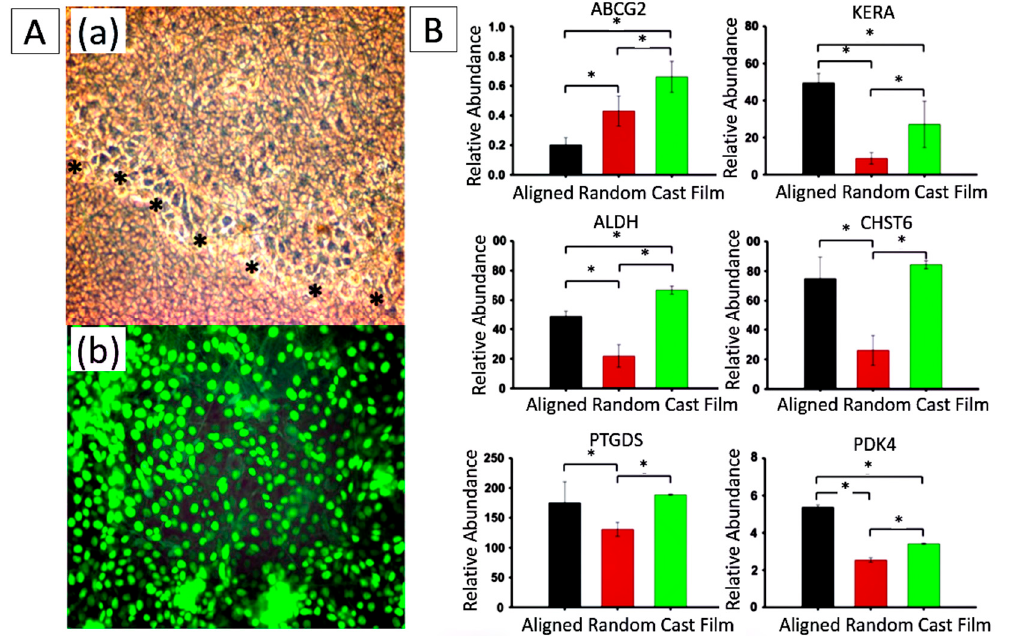
Figure 6. ( A ) Biocompatibility assessment of electrospun PCL nanofibers. ( a ) Phase contrast picture shows migration of human corneal epithelial cells over nanofibers (black stars line); ( b ) Epithelial cell sheet demonstrates high viability ratio of human corneal epithelial cells on nanofibers by their positive green staining. Cells were observed at 200× magnification. Reproduced from [14], with permission from © 2011 Molecular Vision; ( B ) Changes in gene expression of hCSSCs seeded on aligned fibrous substrates (black), random fibrous substrates (red) and cast films (green). mRNA abundance was compared with hCSSCs cultured in SCGM. Ratios of abundance of each transcript between hCSSCs seeded on different substrates cultured in keratocyte differentiation medium and in SCGM are expressed on a linear scale. Since KERA has no expression in hCSSCs cultured in SCGM, it is expressed in an absolute manner. Error bars show the SD of three independent samples. For each gene, expression levels were significantly different between the studied substrates ( p < 0.05), except for CHST6 and PTGDS on aligned fibrous substrate and cast film. Reproduced from [8], with permission from © 2012 Elsevier.